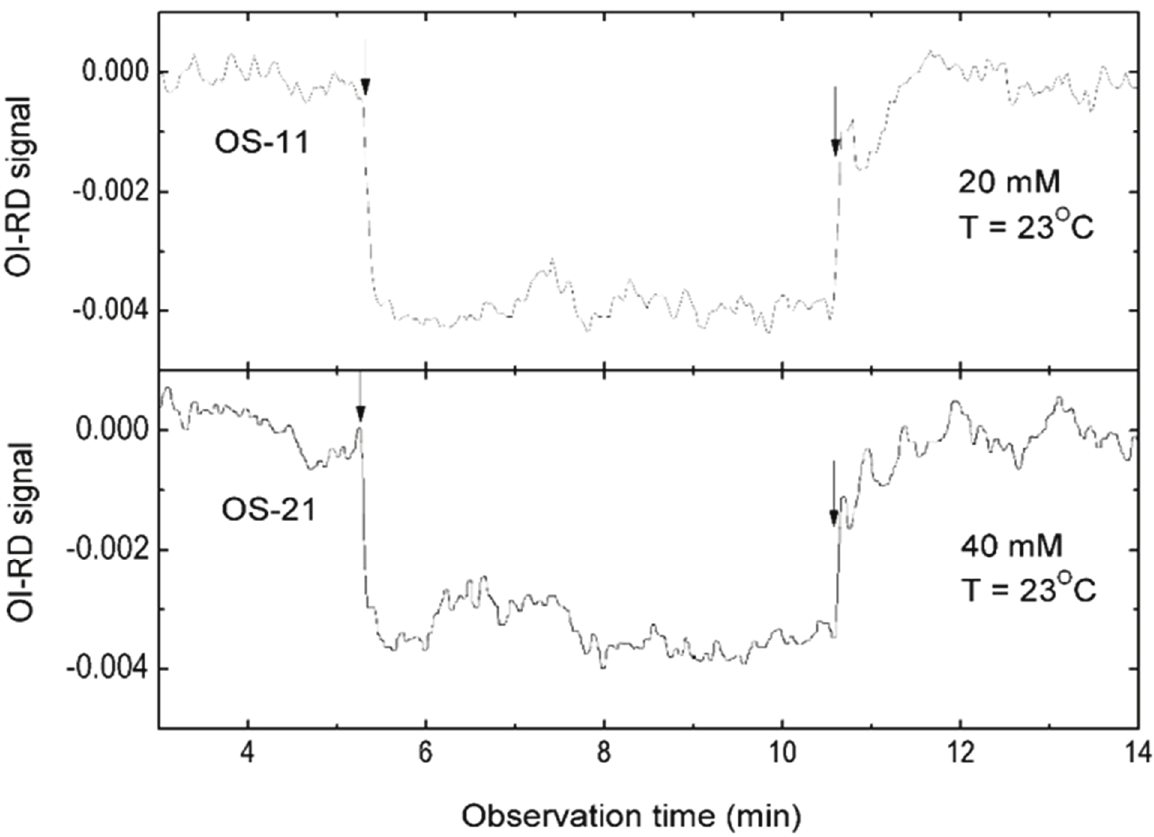
Figure 4. Association-dissociation curves of solution-phase α 2-3-linked sialyllactose (OS-11 without the biotin linker, 20 mM) and α 2-6-linked sialyllactose (OS-21 without the biotin linker, 40 mM) to immobilized A/Mem71 on the solid surface, acquired at 23 ° C (T = 296